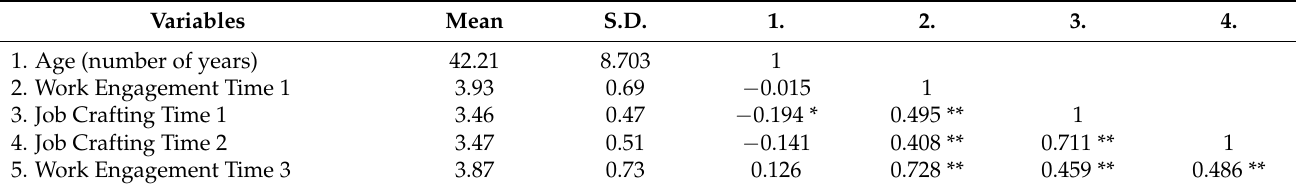
Table 1. Mean, standard deviation, and Pearson’s’ correlations between